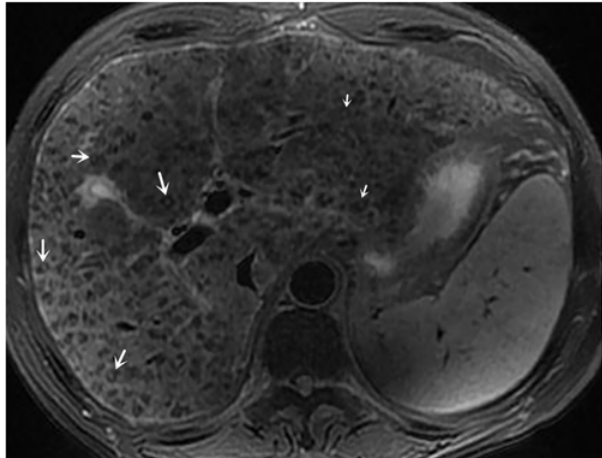
Fig 8. male, 54 years, stage IV with signal grade 3 and halo sign grade